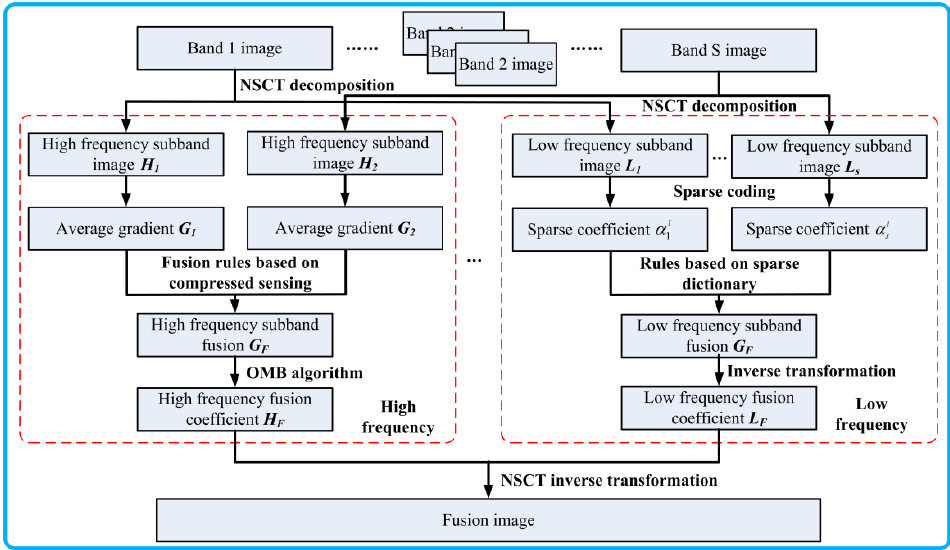
Figure 9. Algorithm framework. The multispectral image sequence { M } is decomposed by nonsubsampled contourlet transform (NSCT) to obtain high frequency sub band images { H 1 , H 2 , … H s } and low frequency sub band images { L 1 , L 2 , … L s }.